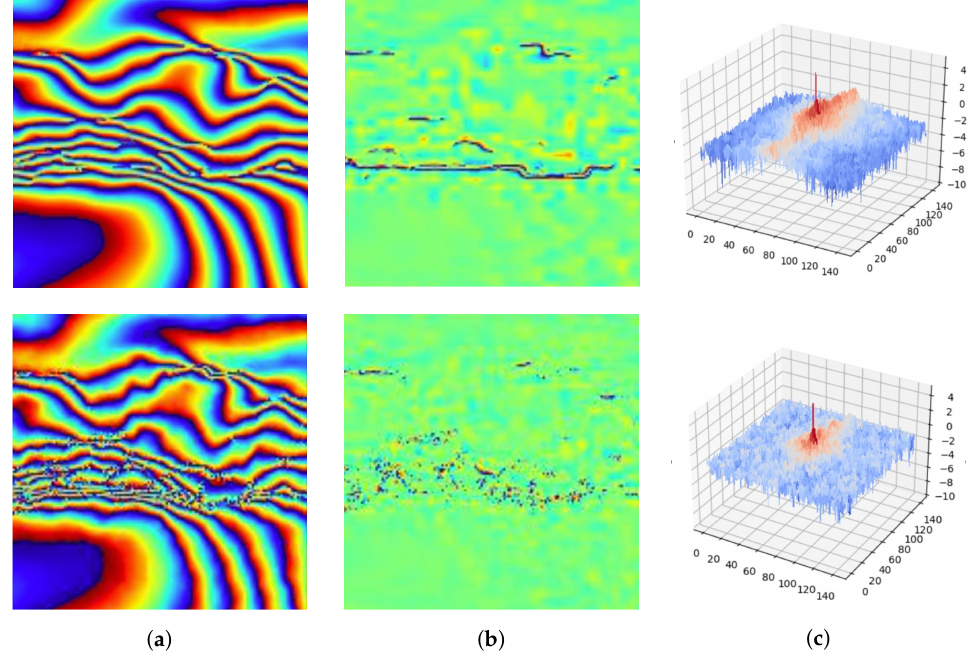
Figure 8. Comparison example between a low- ( top ) and high-spectral-flatness ( bottom ) case. ( a ) Filtered interferometric phase; ( b ) residues; ( c ) residue